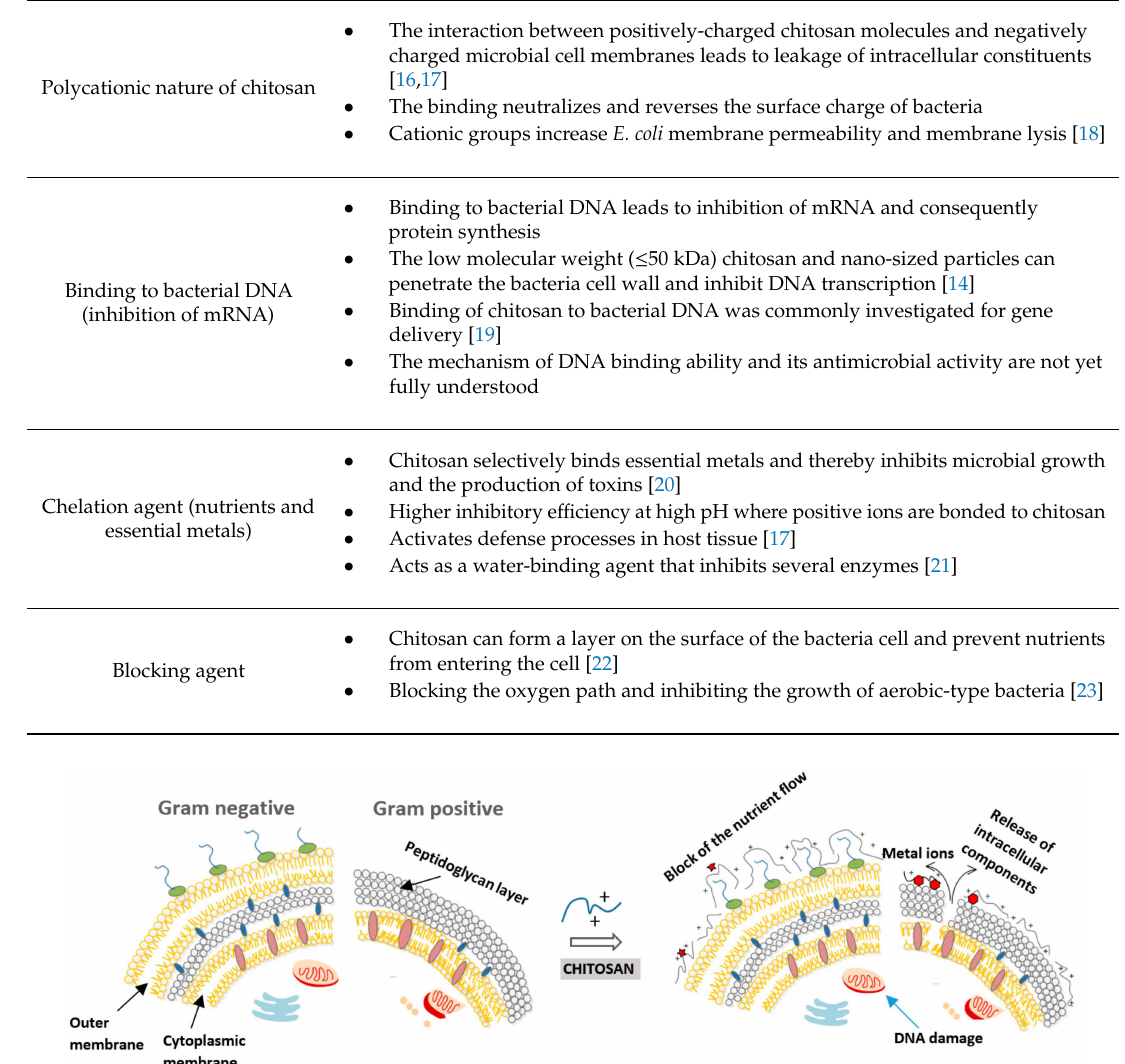
Table 1. Recent studies of various hypotheses on the mechanism of chitosan antimicrobial action. Antimicrobial Mechanism